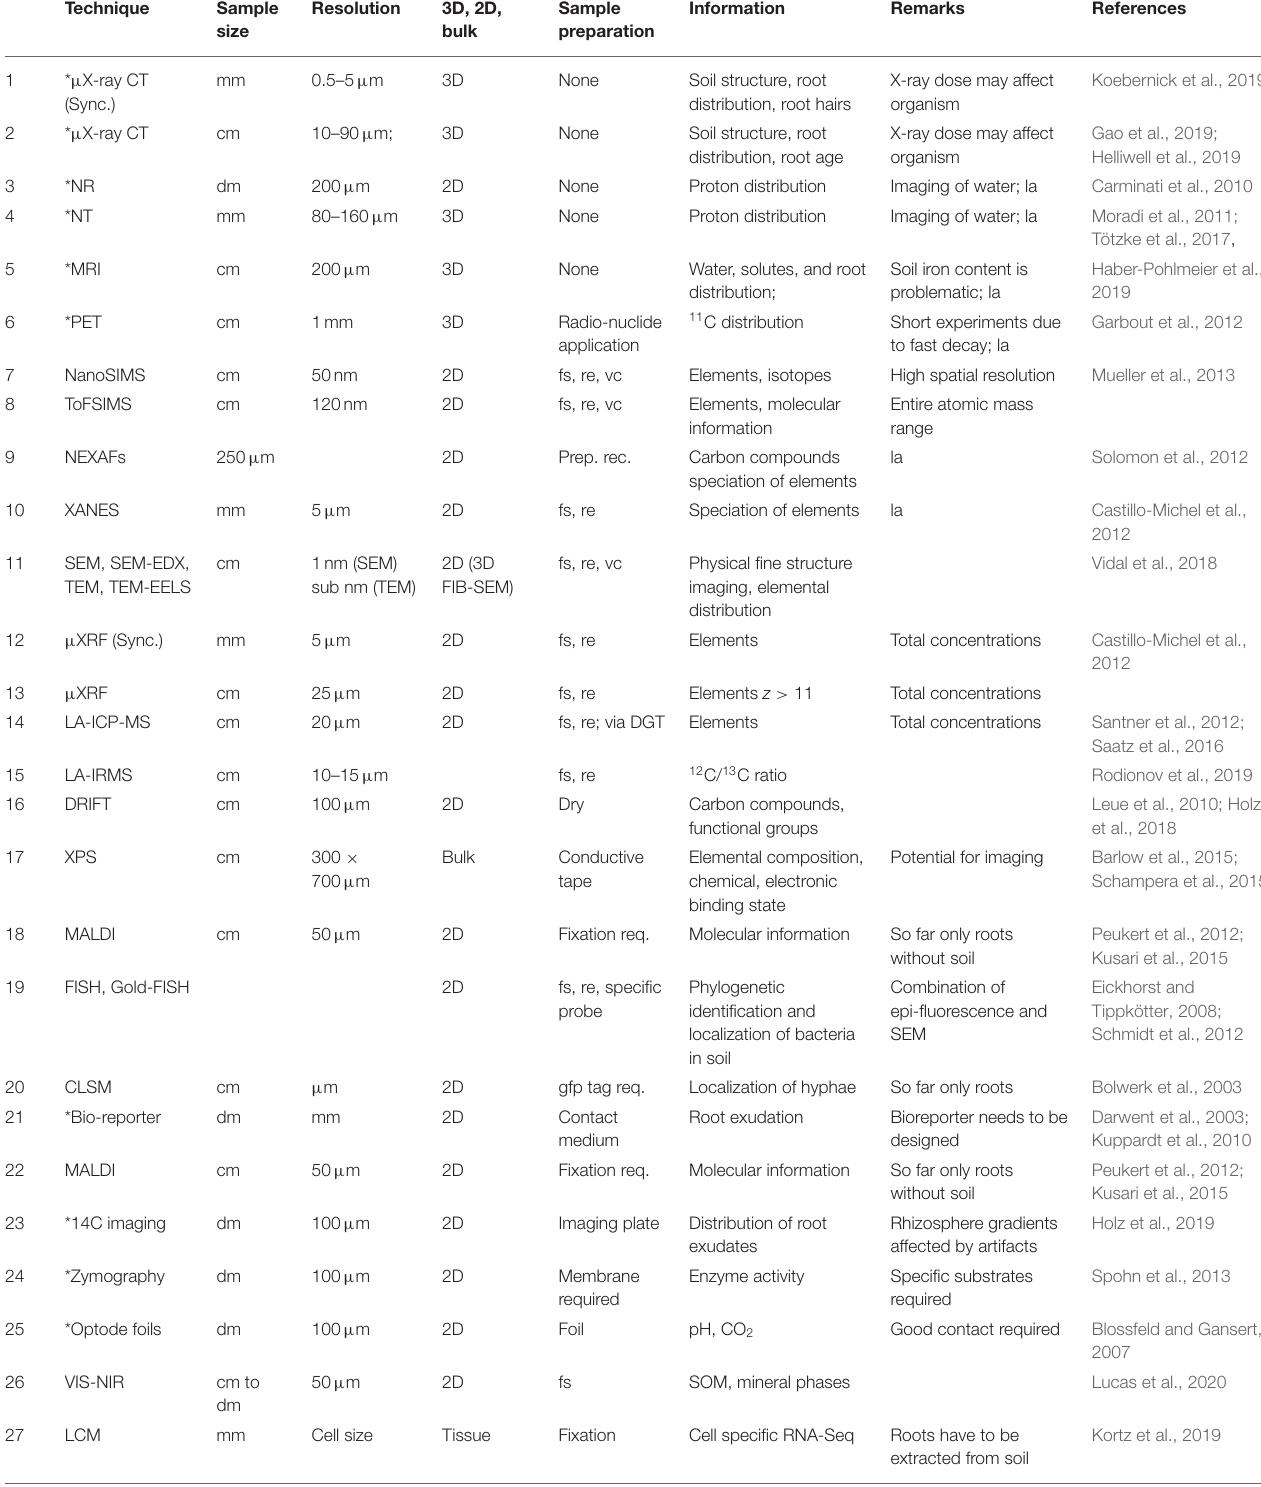
TABLE 2 | Methods suitable or with potential for analyses of rhizosphere spatial patterns and their dynamic in time.